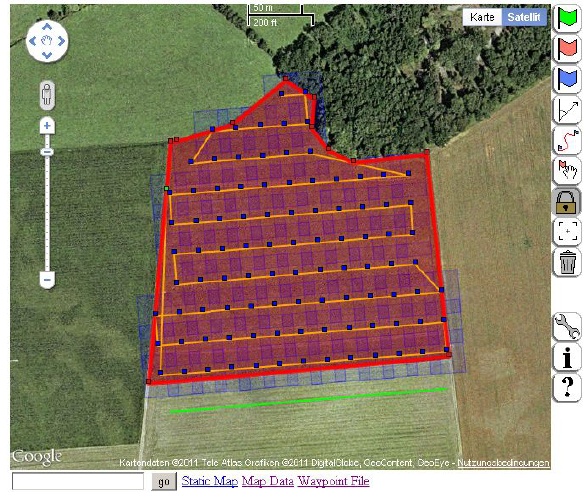
Figure 7: Screen shot of the Waypoint